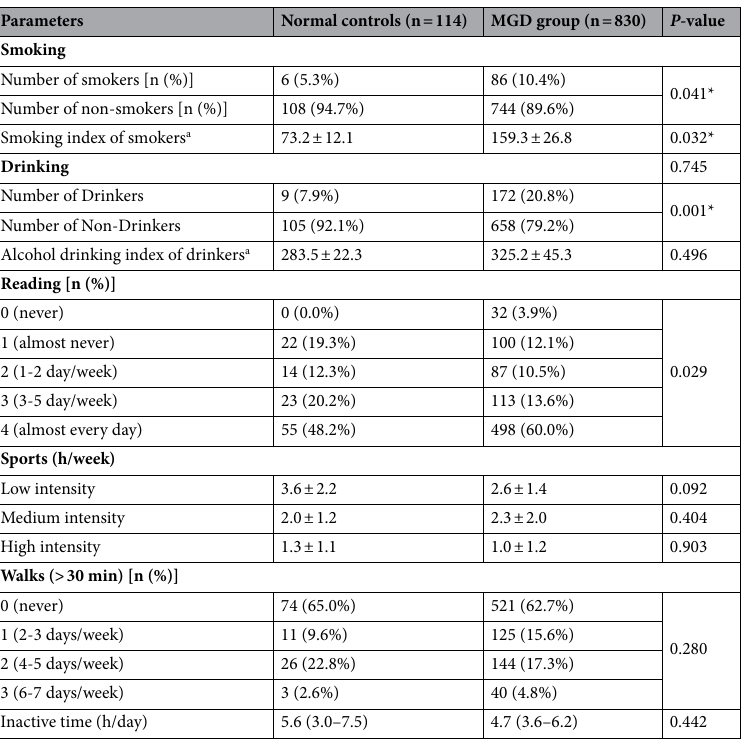
Table 2. Lifestyle habits of MGD patients and normal controls. *P < 0.05 was considered statistically significant. a Smoking and drinking index were calculated as follows: Smoking index = (number of cigarettes consumed per day) × (years of smoking); Alcohol drinking index = (Gram of Liquor consumed per day) × (years of drinking).